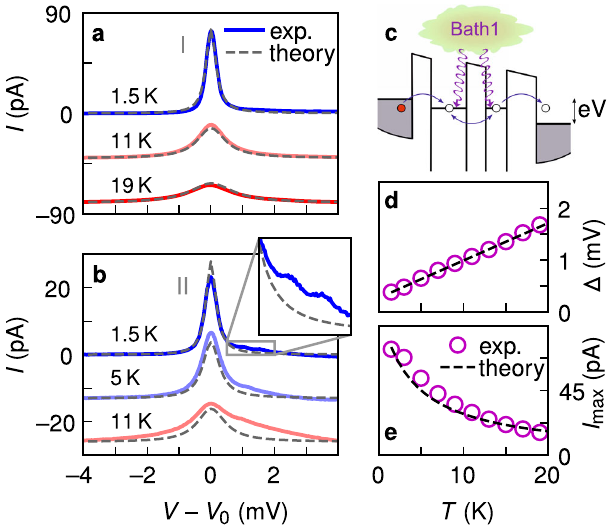
Fig. 2 Analysis of the current peaks. a , b Enlargement of the measured peaks at V 0 ≈ 155 mV (peak I) and V 0 ≈ 188 mV (peak II), respectively, with the background subtracted (solid lines) in comparison with the result of the theoretical prediction with only bath 1 (dashed) for various temperatures. The inset of panel b reveals the presence of two further resonances. c Corresponding model with an environment coupled to the difference of the onsite energies. d , e Width Δ and height I max of peak I in dependence of the temperature. Experimental values are depicted by circles while the dashed line shows the current of the full model with Γ L = 500 μ eV, Γ = 40 μ eV, Ω = 4.2 μ eV, α = 0.01, and α 0 ¼ R